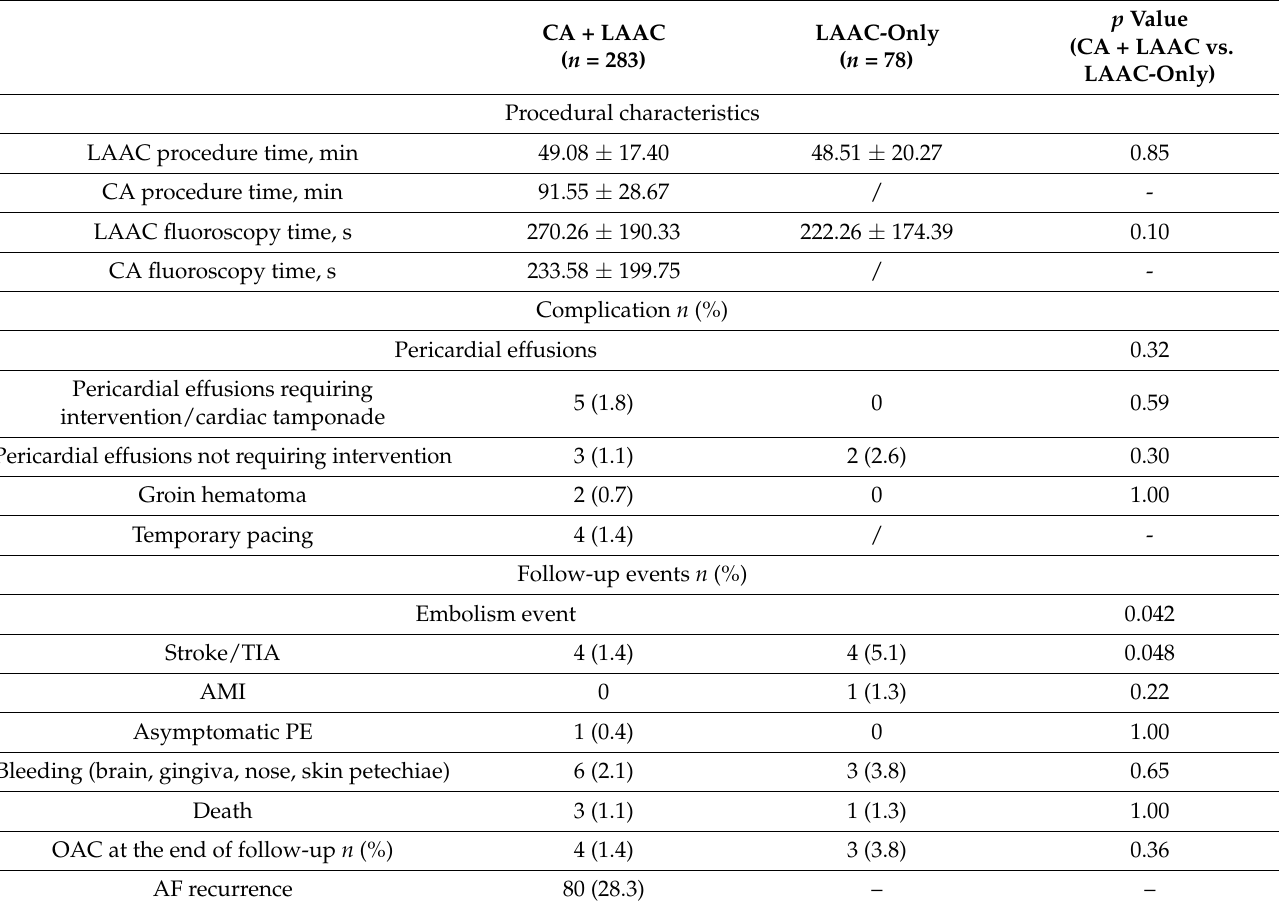
Table 2. Procedural characteristics, procedure-related complications, and follow-up of clinical ad- verse events. CA + LAAC ( n = 283)